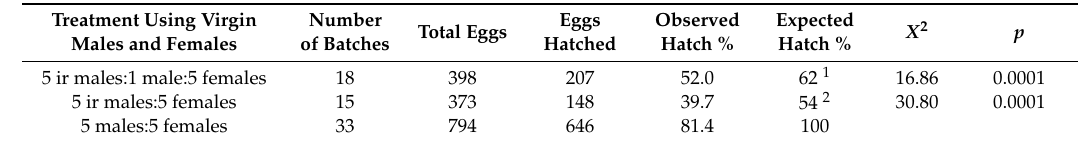
Table 3. Hatch of Halyomorpha halys eggs from oviposition after caging with five-to-one ratios of irradiated (ir, 16 Gy) and untreated virgin male parents placed with five virgin females, compared to untreated controls and undiluted irradiated males (expected values from Table 2). Eggs Observed Treatment Using Virgin Number Total Eggs Males and Females of Batches Hatched Hatch